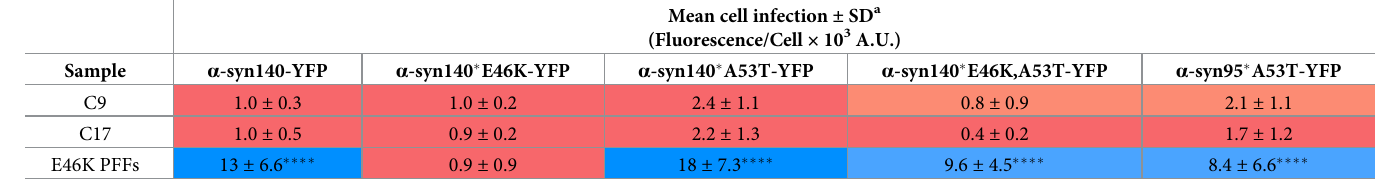
a Colors represent heat map of infectivity with blue indicating high infectivity for a given cell line and red indicating low infectivity for a given cell line. Cell infection data from mice inoculated with samples C9 and C17 reported in Holec, et al., 2022 [46]. ���� = P < 0.0001 compared to control-patient samples C9 and